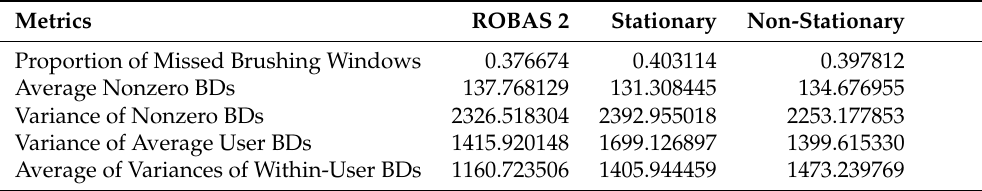
Table A4. Comparing Moments Between Base Models and ROBAS 2 Data Set. Above, we use BDs to abbreviate Brushing Durations. Values for the Stationary and Nonstationary base models are averaged across 100